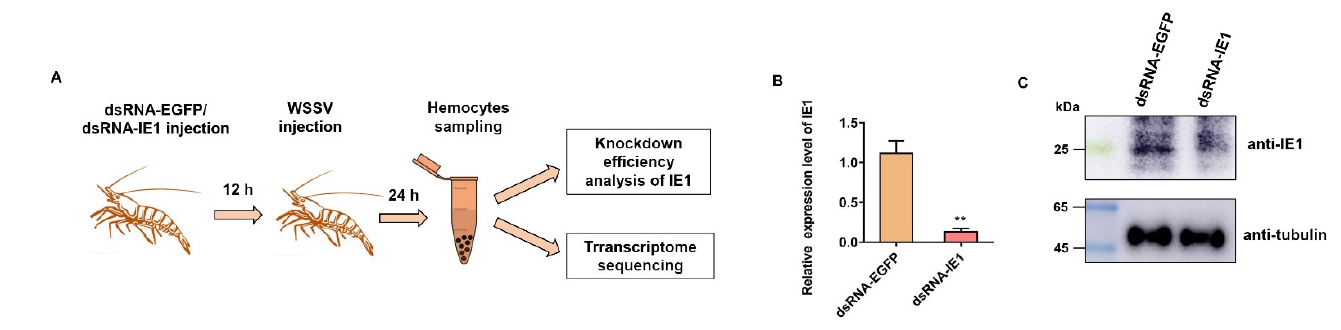
Figure 1. IE1 knockdown and transcriptome sequencing ( A ) Workflow of IE1 knockdown in WSSV- infected shrimp and sample preparations for transcriptome sequencing. ( B , C ) Knockdown efficiency analysis of IE1 using qPCR and Western blot assay. Shrimp were injected with dsRNA-IE1 and dsRNA-EGFP, respectively. At 12 h post dsRNA injection, shrimp of each group were further challenged with WSSV. After infection for 24 h, hemocytes per group were harvested and used for knockdown efficiency analysis of IE1 by qPCR and Western blot analysis, followed by transcriptome sequencing. The qPCR data were shown as mean ± SD, and the statistical significance was computed by Student’s t -test (** indicates p < 0.01).